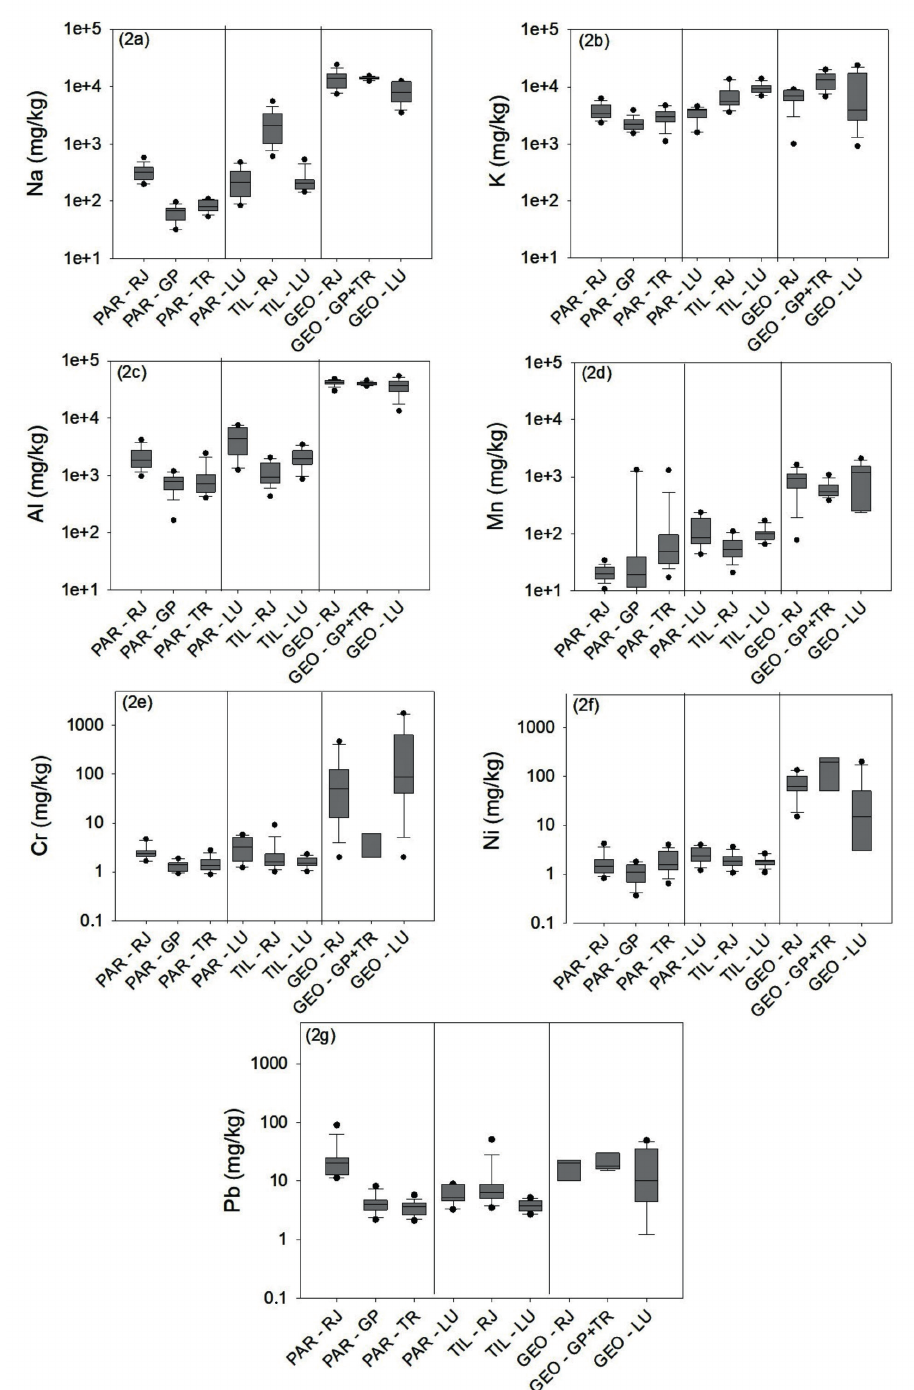
Figure 2 - “Boxplot” of metallic element concentrations (Na, K, Al, Mn, Cr, Ni and Pb) in Parmotrema crinitum (Ach.), Tillandsia usneoides (L.) and rocks from sampling area in Rio de Janeiro